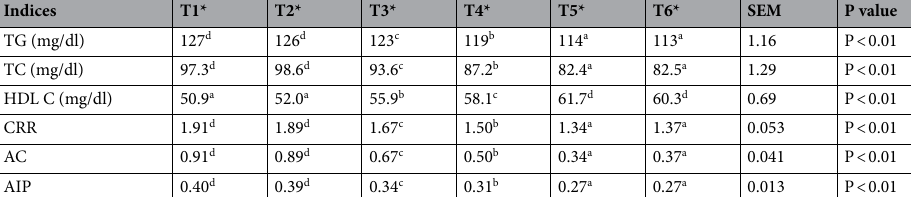
Table 5. Effect of dietary supplementation of Bifidobacterium bifidum (BFD) and Mannan-oligosaccharides (MOS) on serum lipid chemistry and health related indices of broiler chicken (n = 6 × 2). *T1 (no